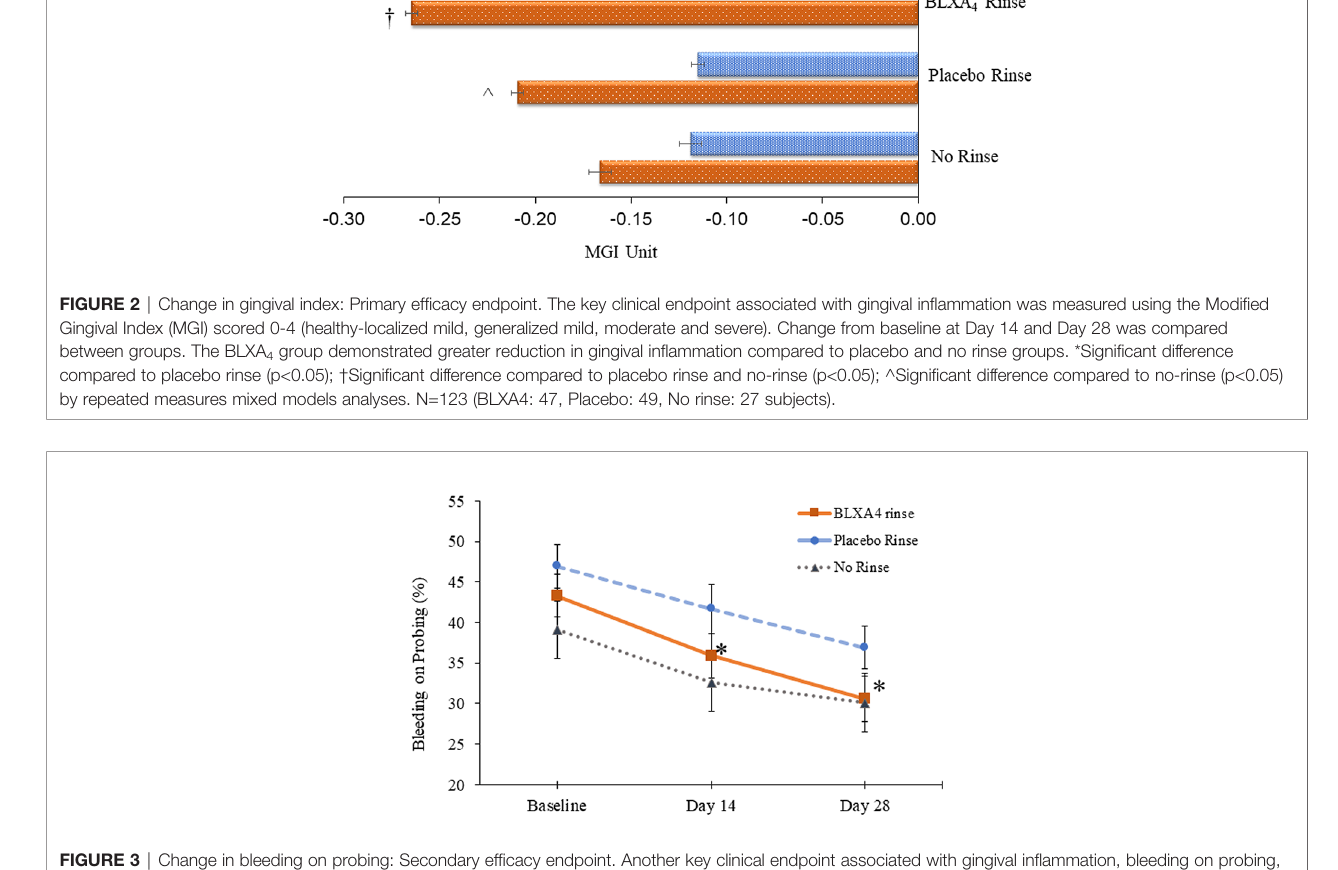
FIGURE 3 | Change in bleeding on probing: Secondary ef fi cacy endpoint. Another key clinical endpoint associated with gingival in fl ammation, bleeding on probing, was measured using a dichotomous measure, as 1=bleeding 0=no bleeding within 15 minutes following probing the site. Change from baseline at Day 14 and Day 28 was compared between groups. The BLXA 4 group demonstrated greater reduction in gingival in fl ammation compared to placebo group at both Day 14 and Day 28 (*p<0.0001; *p=0.0053, respectively); ANOVA for repeated measures followed by Tukey-Kramer test. N=123 (BLXA4: 47, Placebo: 49, No rinse: 27 subjects).